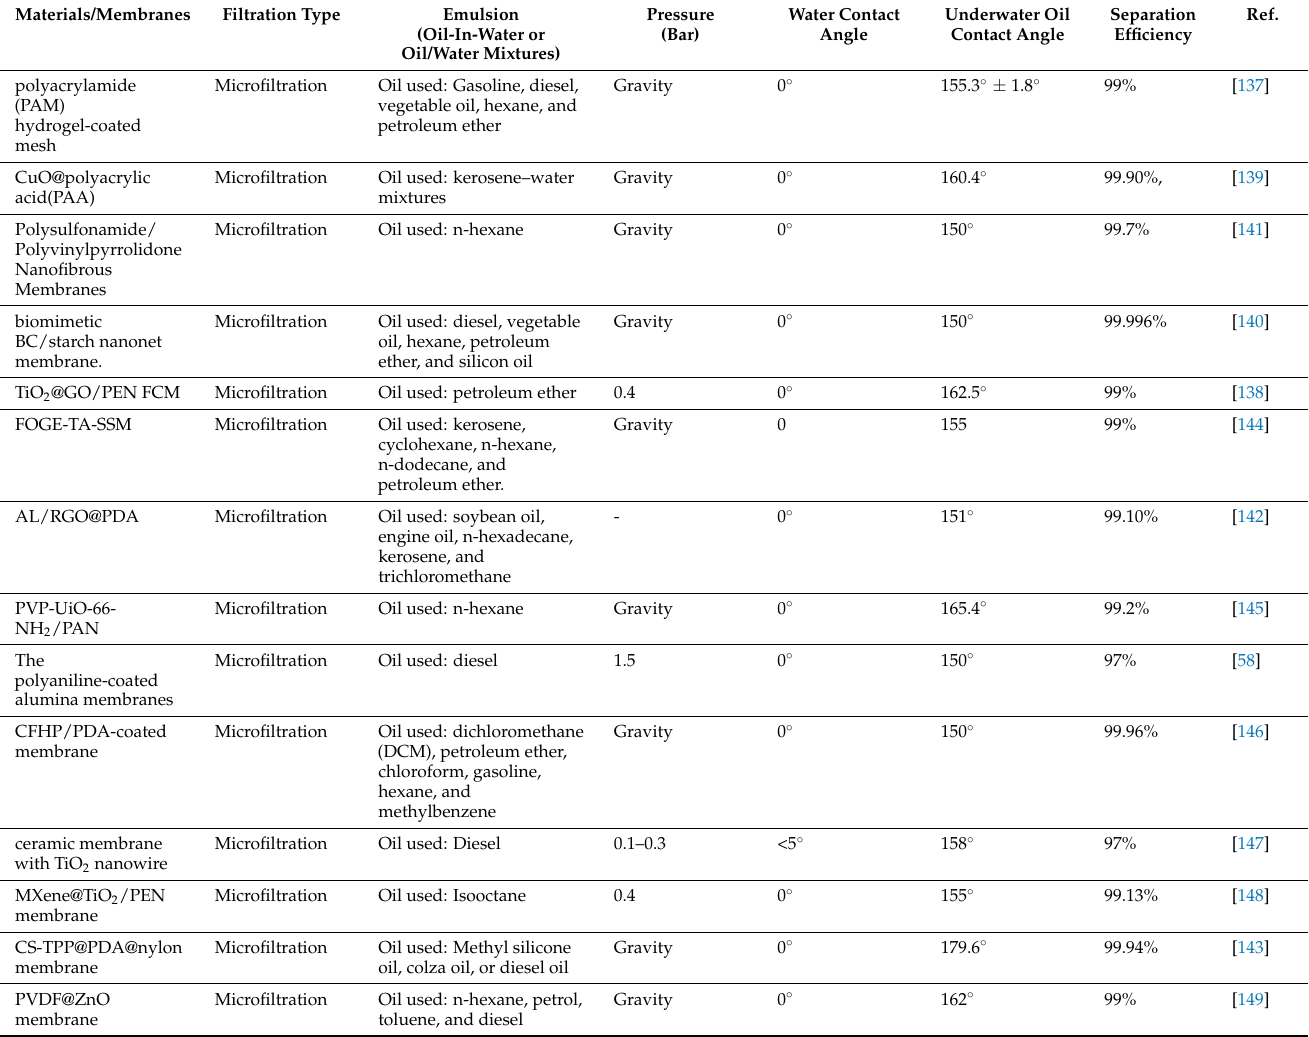
Table 2. Comparison of the performance of the superhydrophilic and superoleophobic membranes for oil/water